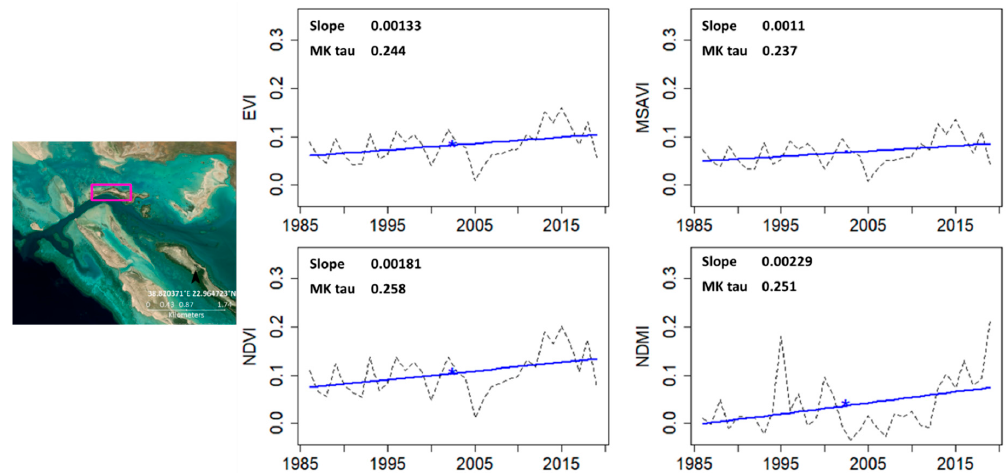
Figure 15. Trend (blue line) analysis for site in extreme northwest (enclosed in pink box). The symbol * shows the trend is significant, with one * meaning p value of equal or less than 0.05.